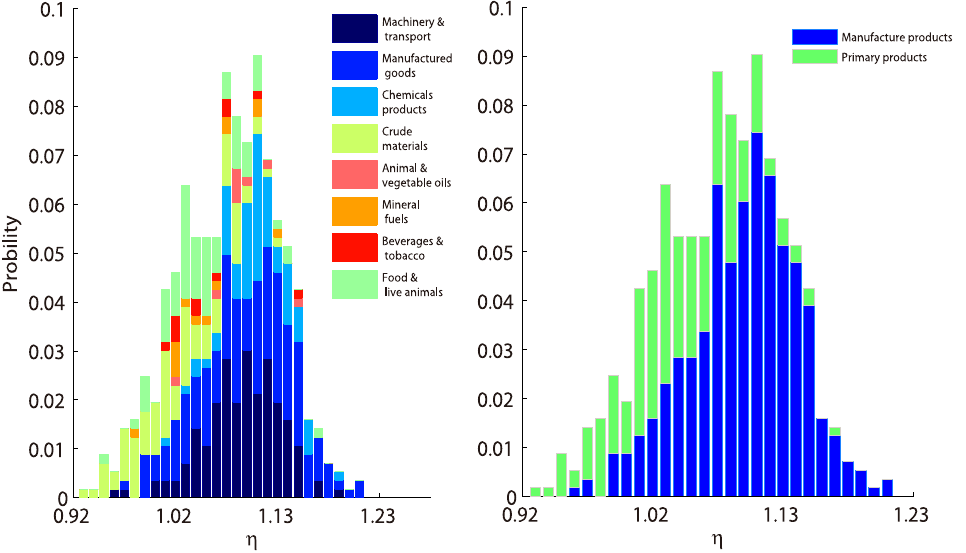
Figure 4. Exponents Distribution for All 4-digit SITC4 Product Categories. The stacked bar charts of different colors correspond to 1-digit SITC4 categories (left) and primary and manufacture classifications (right). For one specific 1-digit classification (say 0 for food and living animals), we can calculate the frequencies on each exponent intervals for all products with 0 prefix, then these frequencies as little bars are stacked on the tops of existing bars.